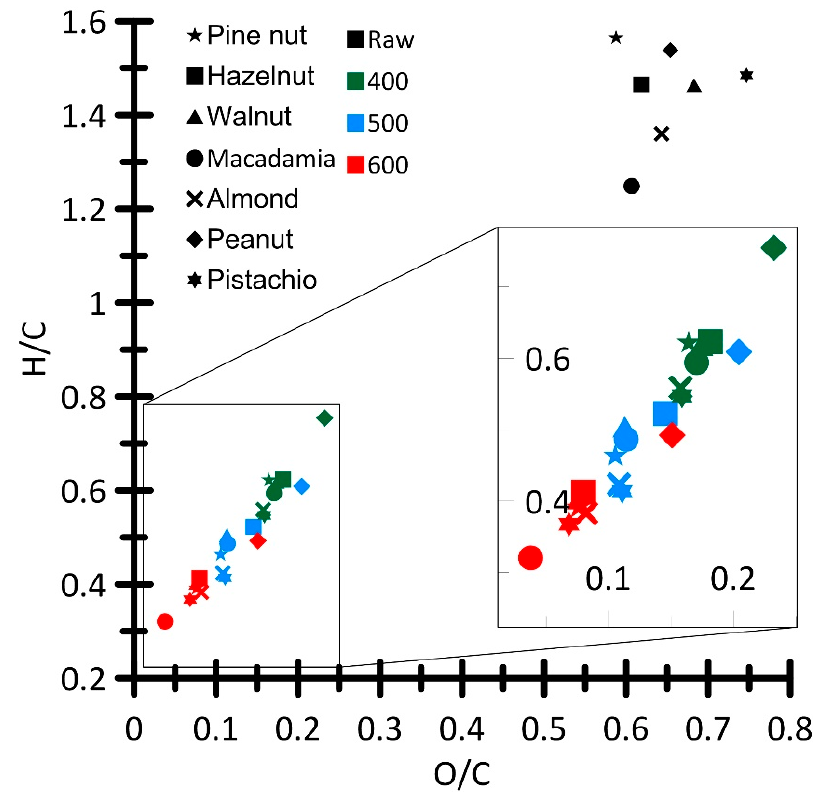
Figure 6. Van Krevelen diagram.